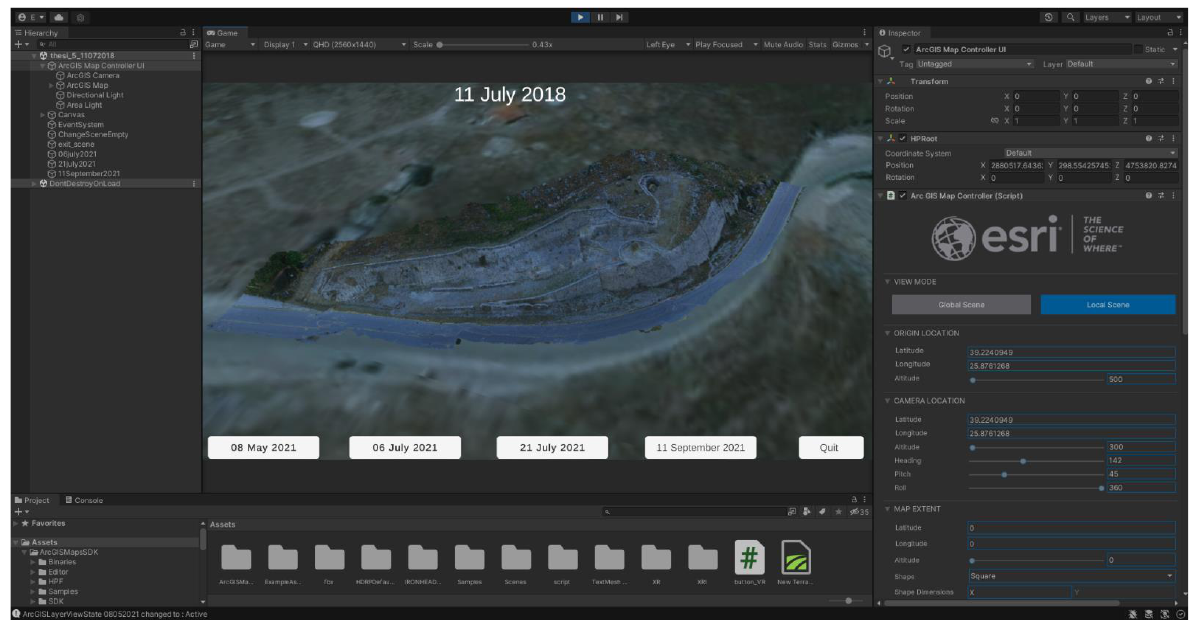
Figure 8. ArcGIS Maps SDK in Unity 3D Engine and the preview of fossilite ferrous site on 11 July 2018.